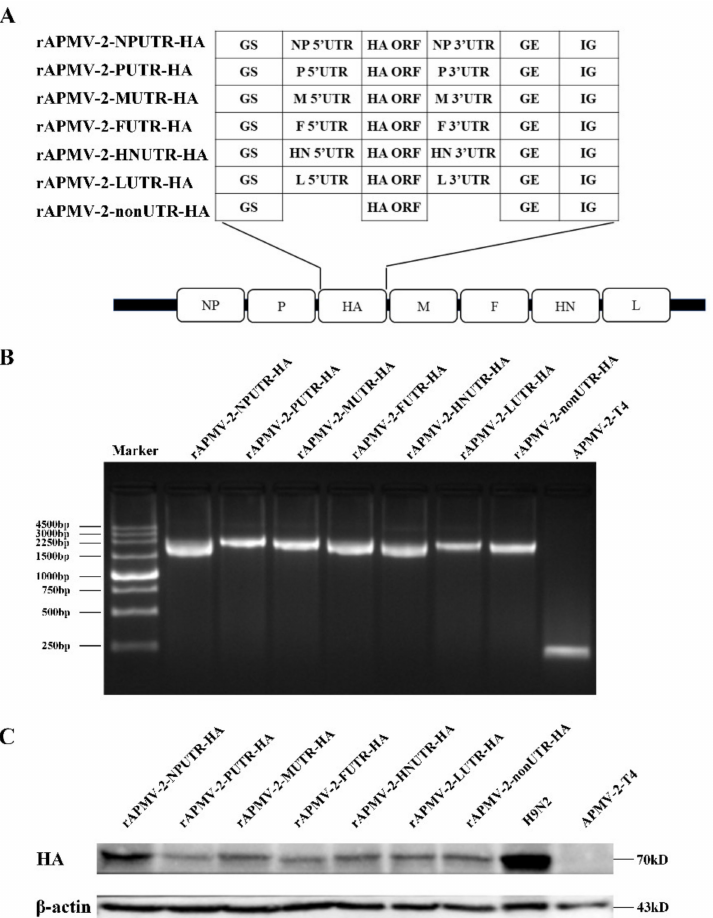
Figure 2. Construction of recombinant avian paramyxovirus serotype 2 (APMV-2) expressing HA gene of H9N2. ( A ) The schematic diagram for the construction of rAPMV-2 expressing HA gene of H9N2. The upstream flanking of the HA gene is the gene start sequences and 5 (cid:48) UTRs for each APMV-2-T4 gene, and the downstream flanking is 3 (cid:48) UTRs for each APMV-2-T4 gene and the gene end sequences. rAPMV-2-nonUTR do not contain any UTRs, only the gene start sequence and gene end sequence. All chimeric structures were inserted between the P and M genes in the APMV-2-T4 genome. ( B ) The allantoic fluid of rAPMV-2/HAs and APMV-2-T4 were collected, respectively, for PCR analysis. ( C ) Expression level of the HA proteins in rAPMV-2/HAs were confirmed by western blot analysis in infected CEF. Equal protein loading was confirmed with the β -actin